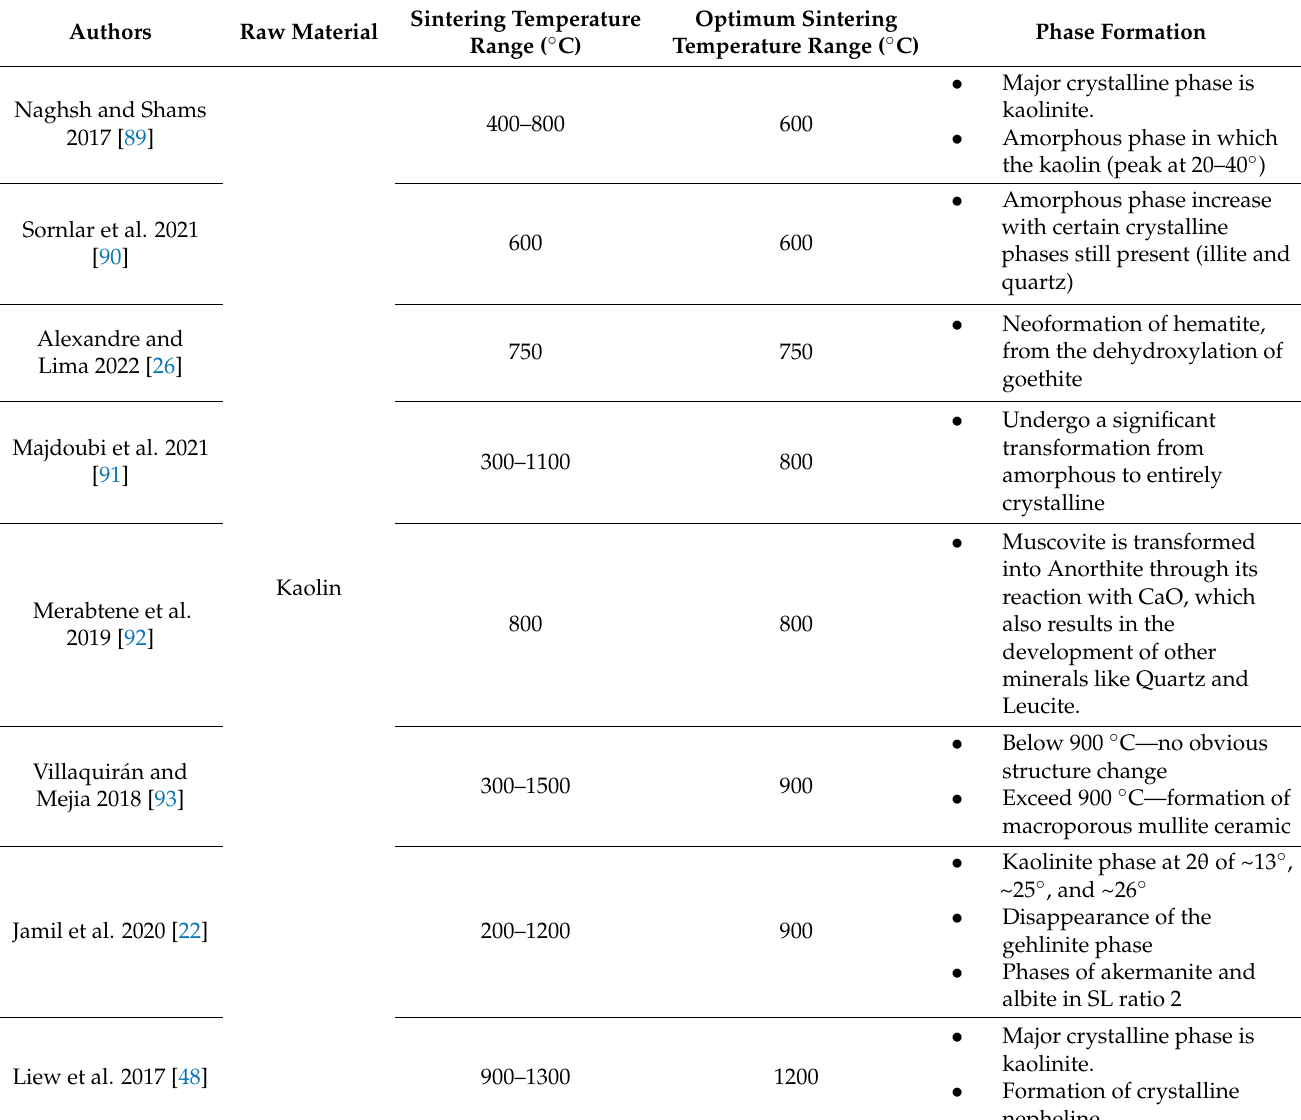
Table 5. Sintering temperature from past